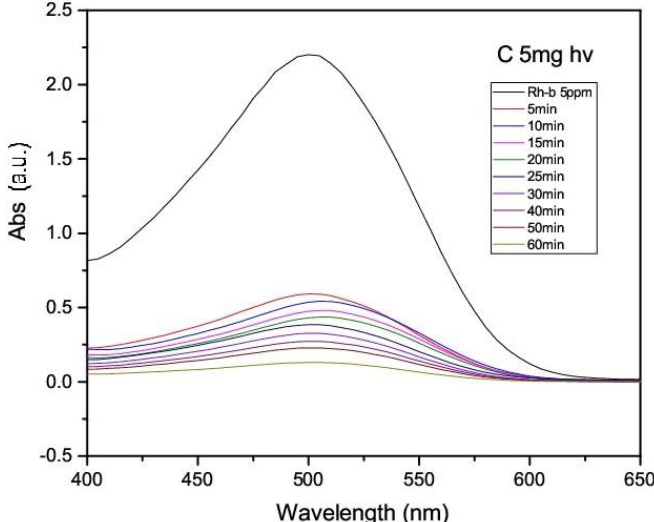
Fig.7 UV – Visible spectra of Rh-B with C NPs at a time interval of 5 minutes from 0 to 60 minutes